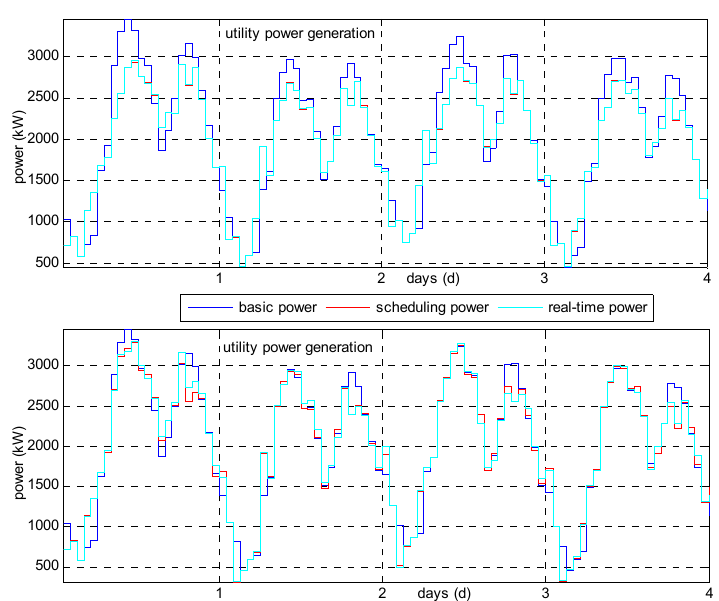
Figure 3. Utility generation for DMPC and DDA strategies in different cases.